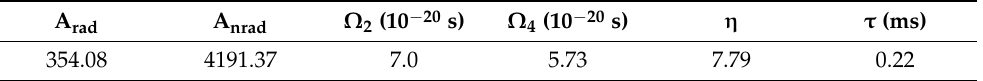
Table 2. Experimental luminescence parameters. Experimental Nonradiative (A nrad ), Radiative (A rad ) Decay Rates; Intensity Parameters Ω 2 and Ω 4 ; Quantum Efficiency ( η ) and lifetime ( τ